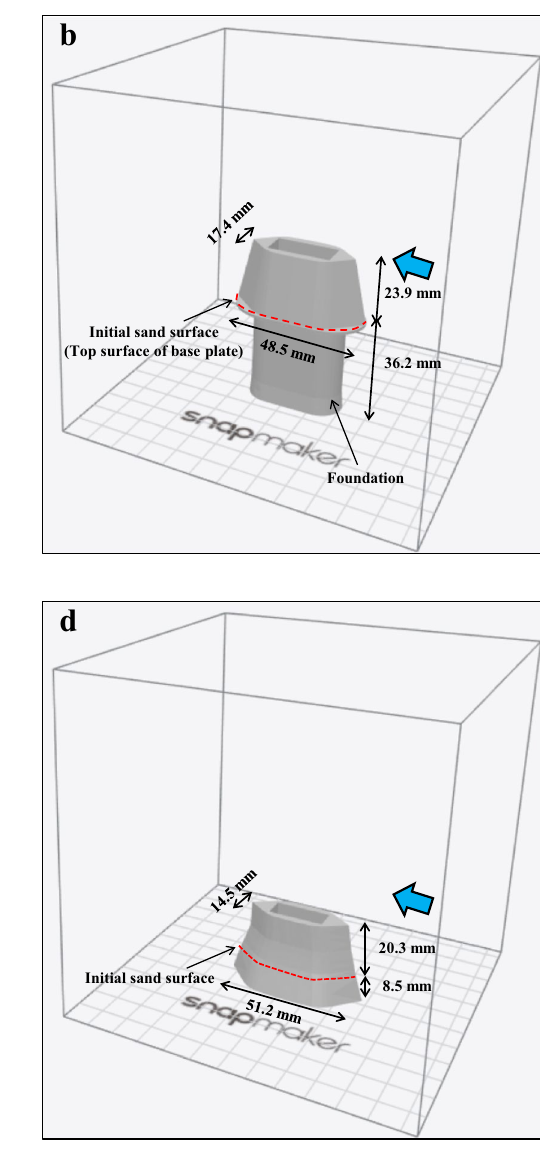
Figure 5. 3D model of piers. ( a ) current piers 1 and 4, including skewed; ( b ) current piers 2 and 3, including skewed; ( c ) old (spindle type); ( d ) old (current type). Reproduced using CAD data provided by Iwakuni City and from JACAM figures 41